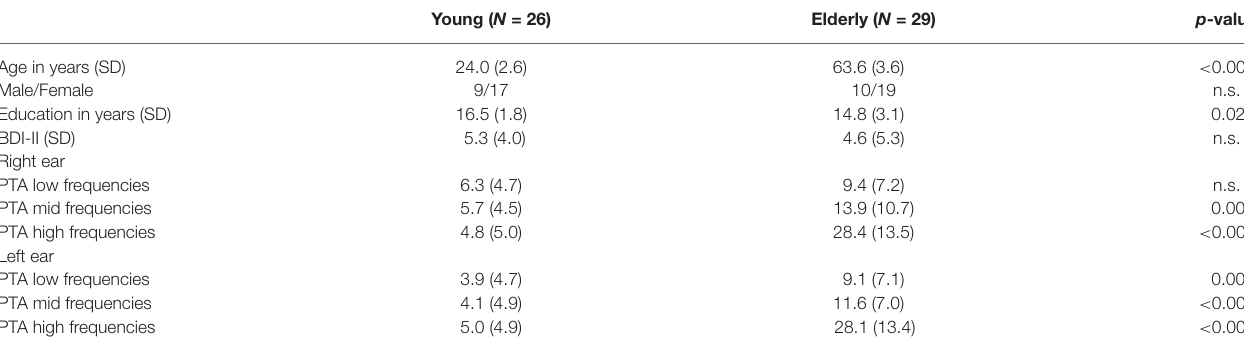
TABLE 1 | Socio-demographic characteristics (standard deviation, SD) of Young adults and Elderly.